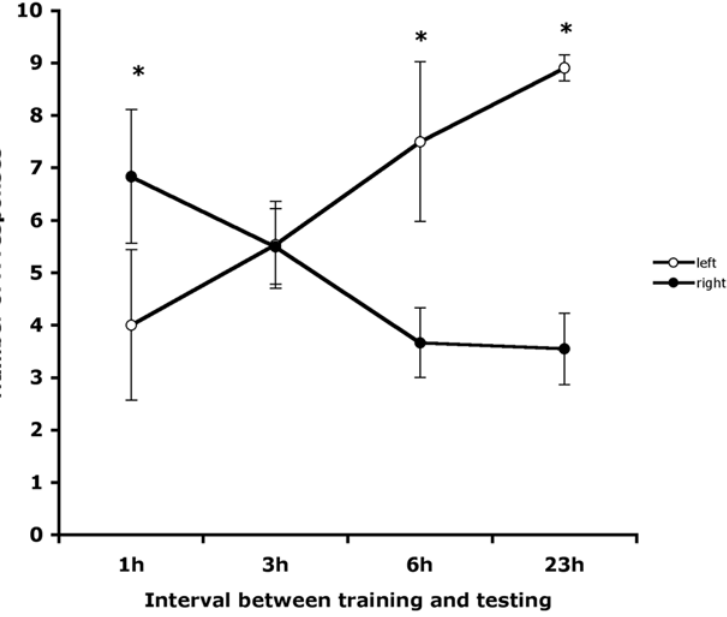
Figure 3. The mean number of A responses, plotted with standard error bars, in recall tested at various intervals after training is shown for presentations of the odours on the bee’s left side (open circles) or right side (closed circles).